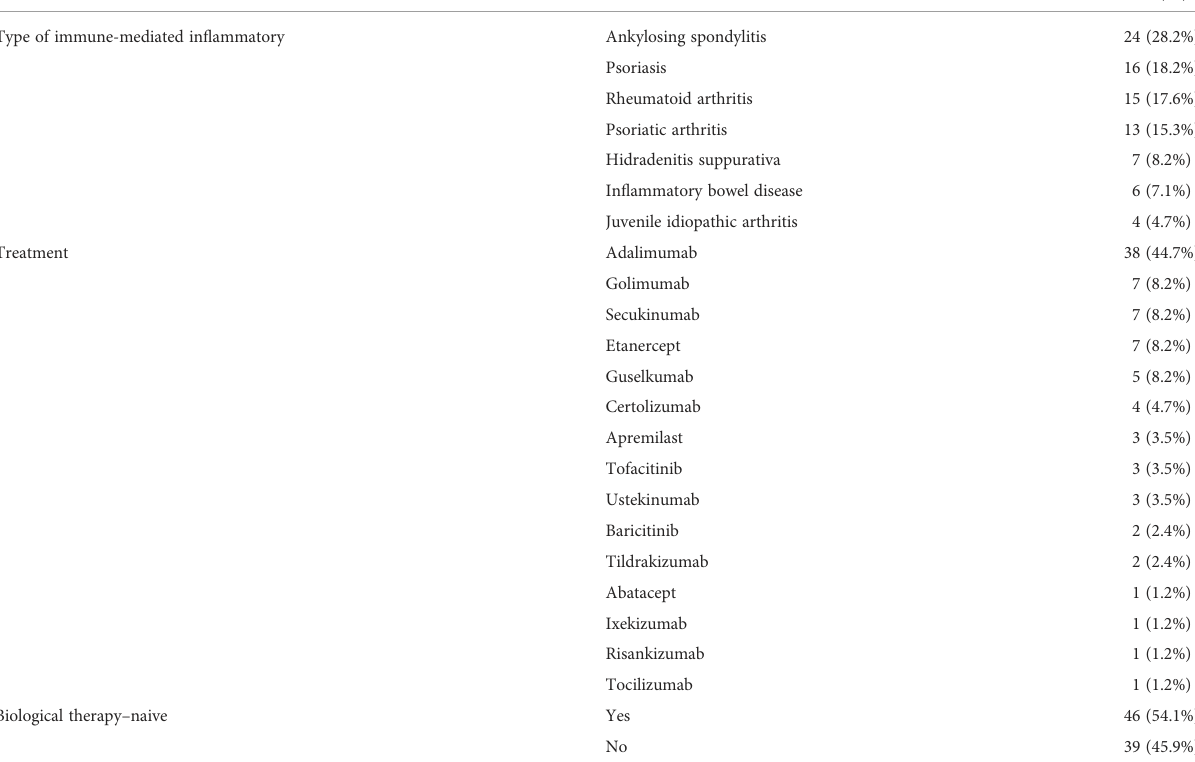
TABLE 2 Type of immune-mediated in fl ammatory diseases and biological therapy used. CHARACTERISTIC